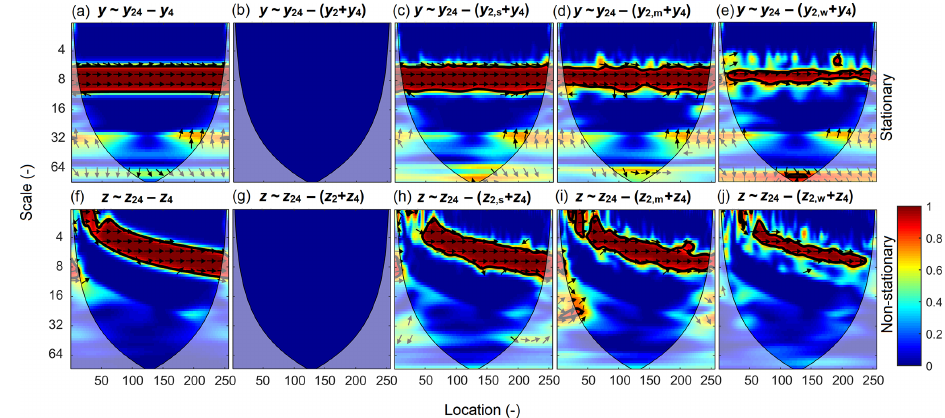
Figure 2. PWC between response variable y (or z ) and predictor variable y 24 (or z 24 ) after excluding the effect of variables y 4 (or z 4 ), y 2 + y 4 (or z 2 + z 4 ), y 2 , s + y 4 (or z 2 , s + z 4 ), y 2 , m + y 4 (or z 2 , m + z 4 ), and y 2 , w + y 4 (or z 2 , w + z 4 ) for the stationary (or non-stationary) case using the new method. All variables were generated by following Yan and Gao (2007) and Hu and Si (2016) and are explained in Sect. 3.1 and shown in Fig. S2 of Sect. S3.